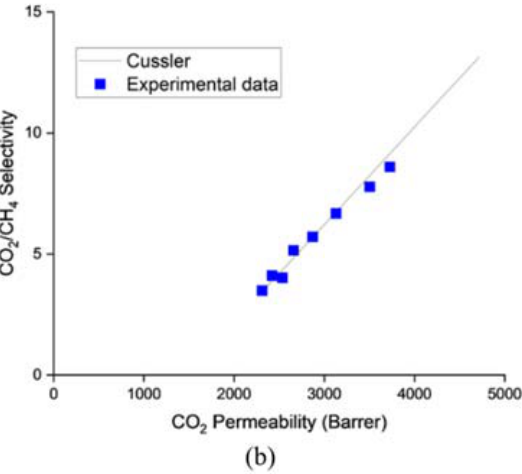
Figure 5. Plot of Cussler model and experimental data obtained in this study for ( a ) CO 2 /N 2 and ( b ) CO 2 /CH 4 gas pair.